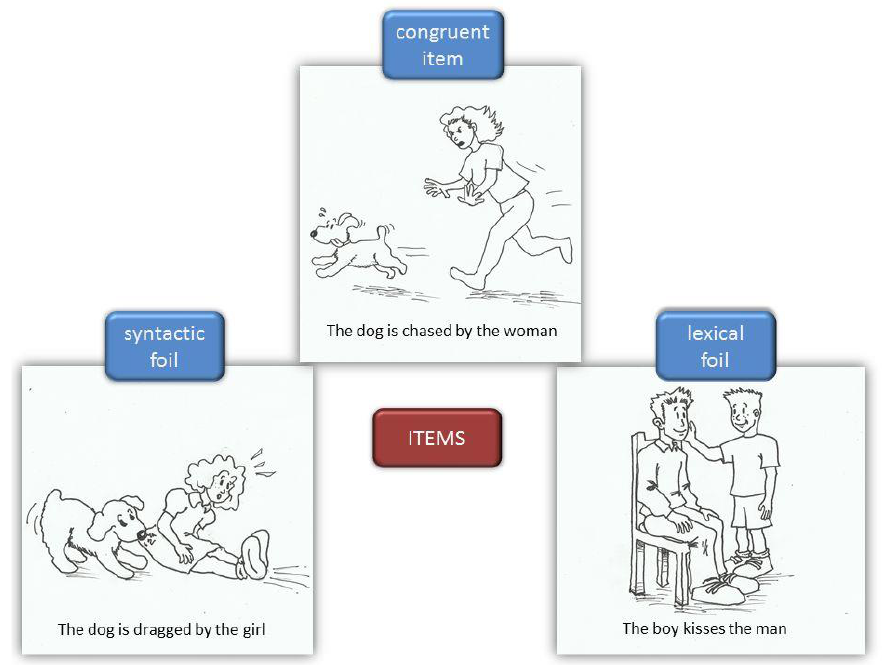
Figure 1. Types of items and examples from ECCO_Senior. Table 2. Sentence structure types included in the ECCO_Senior